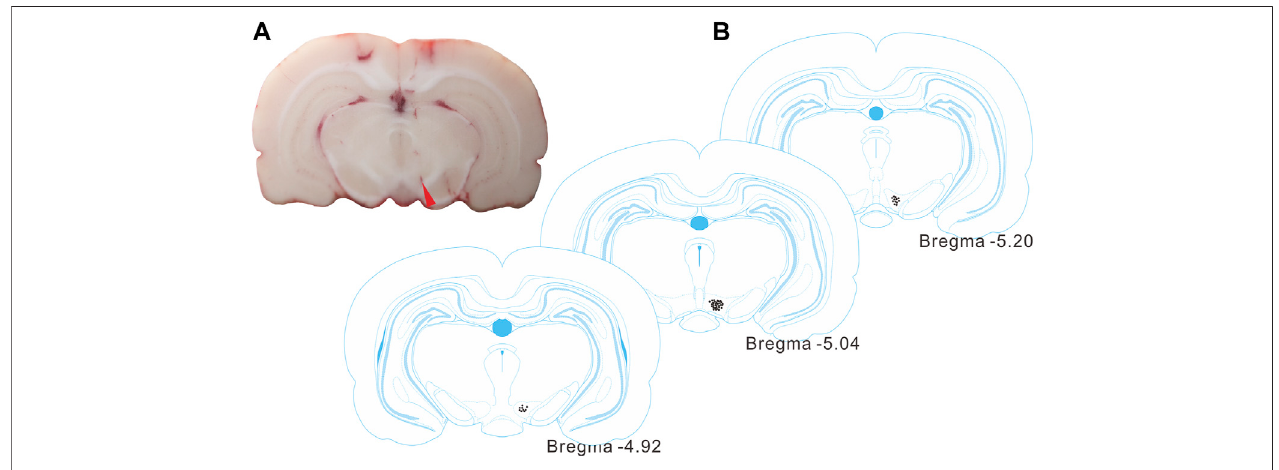
FIGURE 3 | Identi fi cation of the recording site in the VTA. (A) A representative histological section from a rat brain showing the electrode site (red arrowhead). (B) Histological reconstructions showing the recording sites in VTAs (between -4.92 and -5.20 mm from bregma) according to the rat brain atlas.